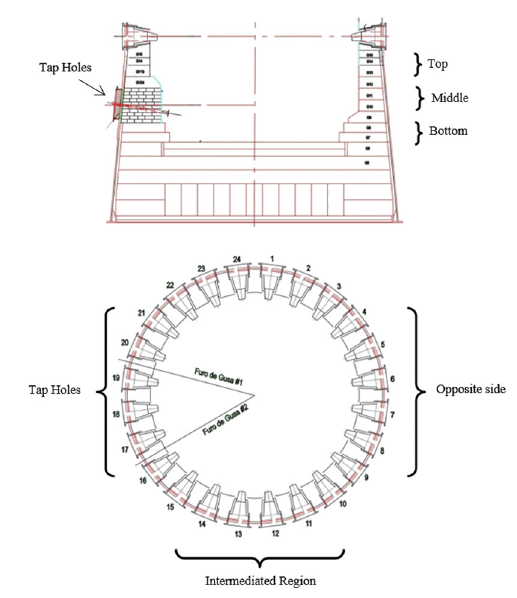
Figure 1. #2 Blast furnace hearth profile showing the region that the samples were collected.